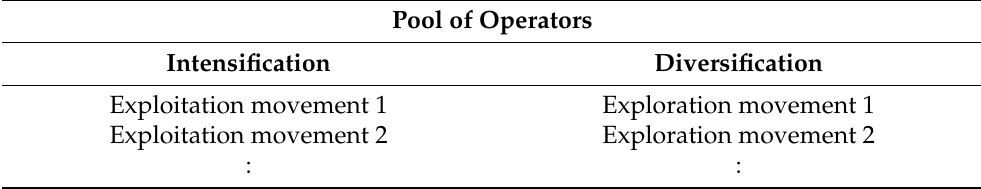
Table 2. Organisation example of the pool of movement operators from